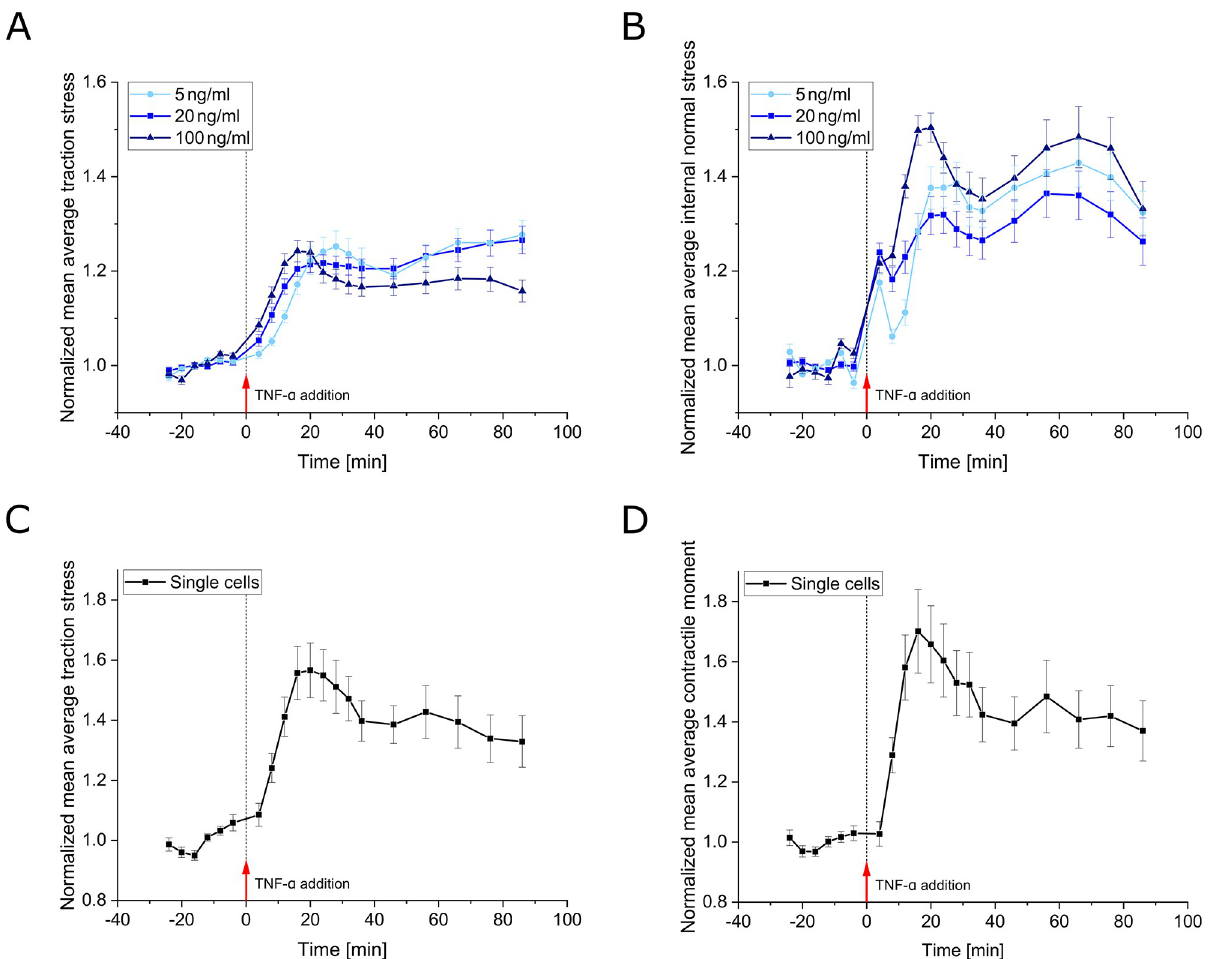
Fig 6. Time evolution of the mechanical response upon TNF- α exposure for different cytokine concentrations and for single cells. A,B : Time course of the mean of spatially averaged (A) traction stress and (B) internal normal stress of multiple monolayer islands recorded at baseline and upon TNF- α treatment for 3 different concentrations as indicated. Data is shown as mean ± SEM and has been normalized to the mean of the first 6 time points recorded prior to cytokine administration for each individual monolayer island. For each concentration, 3 independent experiments were performed with a respective number n 5ng = 29, n 20ng = 29 or n 100ng = 33 of monolayer patches. No clear difference in strength of the response can be observed for the different concentrations. However, the response appears to occur slightly faster with increasing cytokine concentration. As a result, the drop in internal normal stress after the first steep rise, which is caused by our administration procedure, appears progressively reduced. C : Same as A, but for single endothelial cells instead of EC monolayers and at a 20 ng/ml TNF- α concentration only ( n = 26, N = 3). Single ECs display, qualitatively, the same response to TNF- α as EC monolayers while reaching significantly higher peak values ( p < 0.001 at 20 min peak). D : Same as C, but the contractile moment is shown instead of the traction stress for the same cells as in C. Here, the contractile moment serves as a measure of intracellular stress as compared to the internal normal stress in the case of monolayers of ECs. However, no initial intermediate peak is found here but the time course rather matches the one observed for the average traction